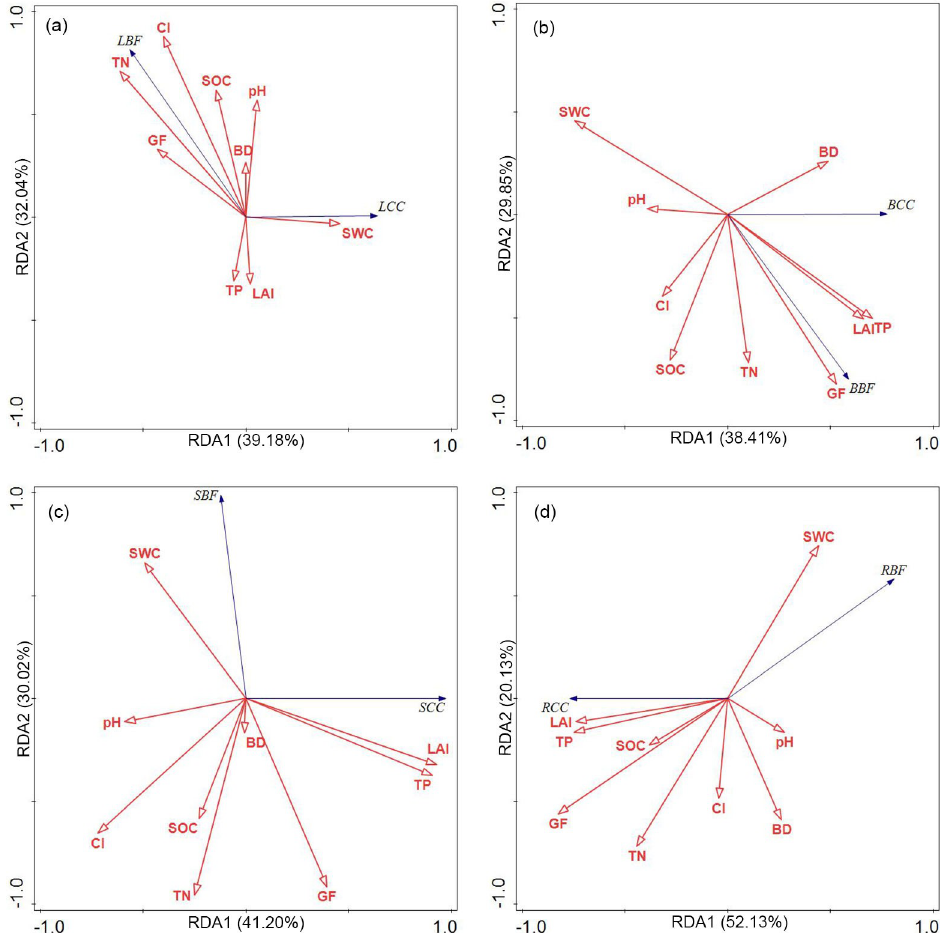
Fig 2. Ordination diagrams generated by redundancy analysis of the effects of environmental factors on biomass fraction and carbon concentration of leaf (a), branch (b), stem (c), root (d). Purple arrows represent biomass fraction and carbon concentration; red arrows represent environmental factors. CI: clumping index; LAI: leaf area index; GF: gap fraction; SOCD: soil organic carbon concentration; TP: total phosphorus; TN: total nitrogen; SWC: soil water content; BD: bulk density; LBF: leaf biomass fraction; LCC: leaf carbon concentration; BBF: branch biomass fraction; BCC: biomass carbon concentration; SBF: stem biomass fraction; SCC: stem carbon concentration; RBF: root biomass fraction; RCC: root carbon